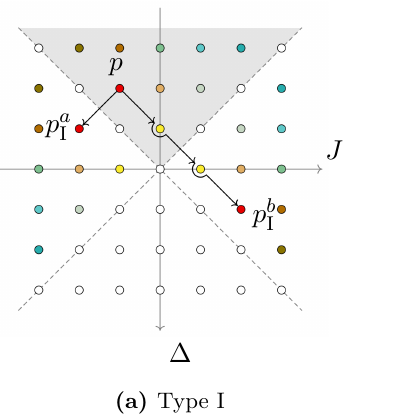
Figure 2. Primary descendants of type I and II. The dots define the integer lattice Z 2 in the J - ∆ plane. The origin is at (∆ , J ) = (1 , 0) . Dots in the grey regions correspond to primaries that have primary descendants. The latter are obtained by reflecting across the dashed lines.